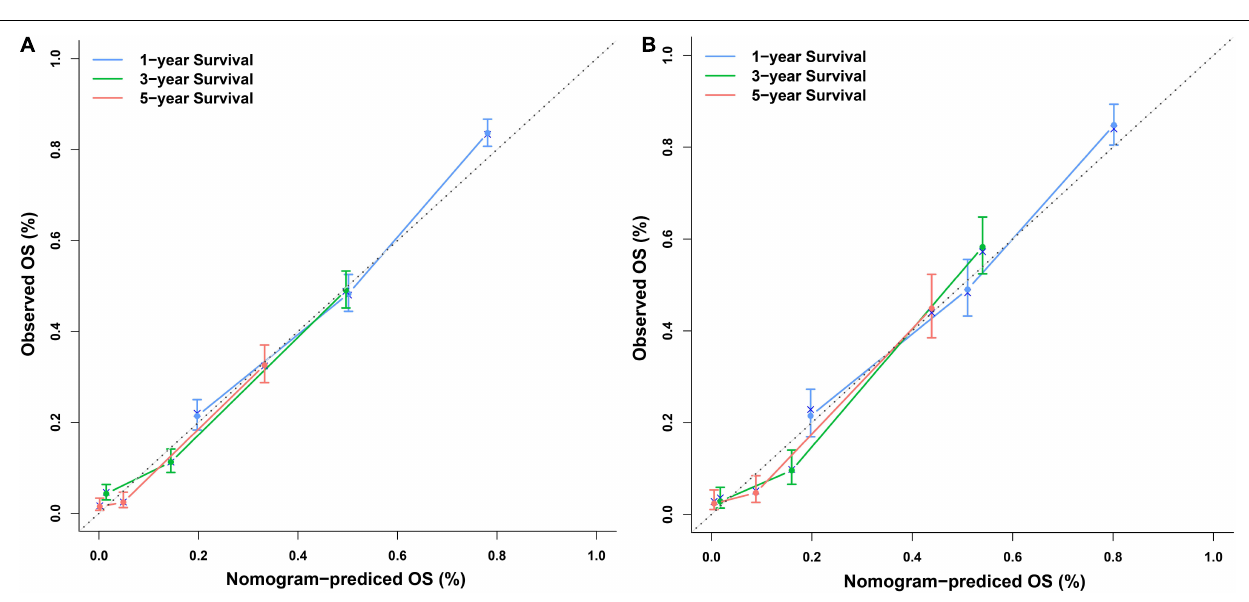
The incidence of ICCA is increasing worldwide (14,